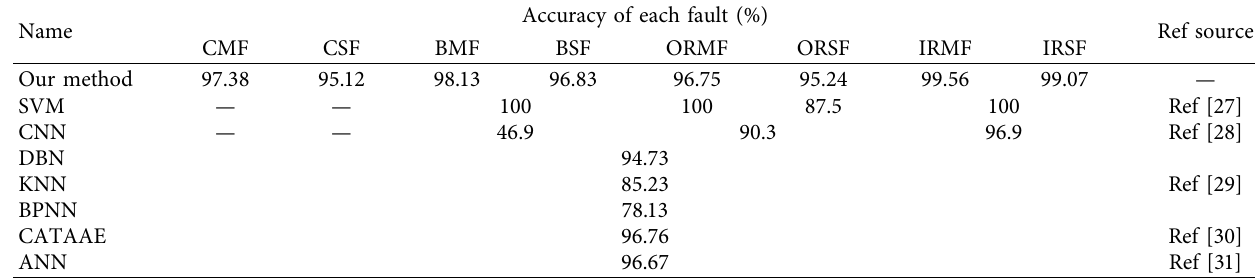
Table 5: Accuracy comparison table.